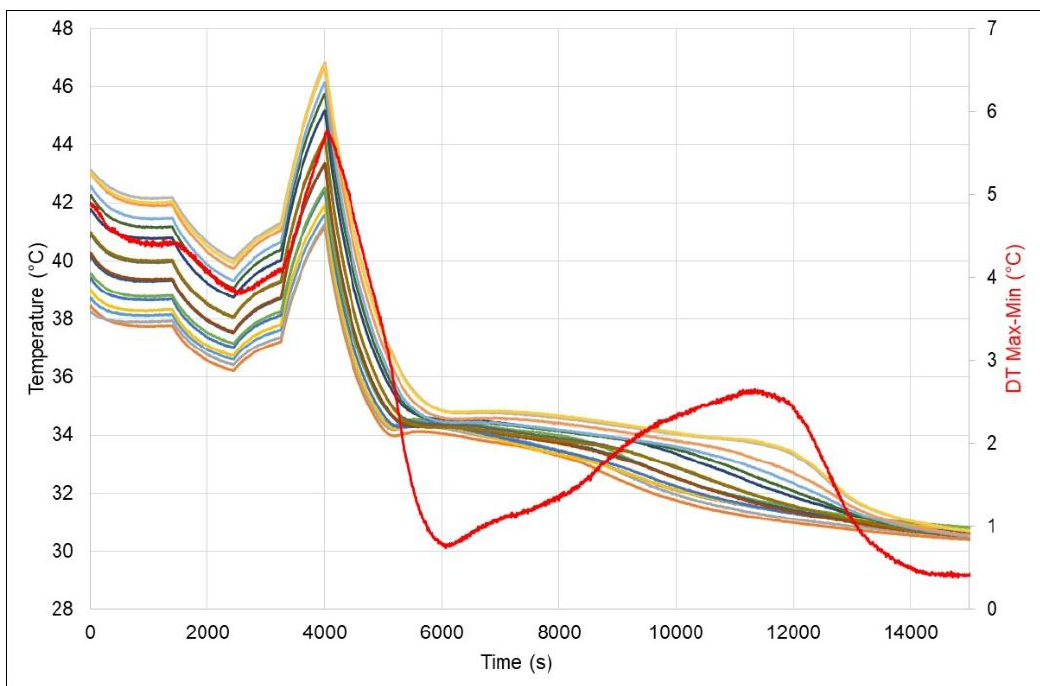
Figure 26. Experimental results with initial temperature of the mockup equal to 40 °C and an airflow characterized by V = 1 m/s and T = 30 °C.